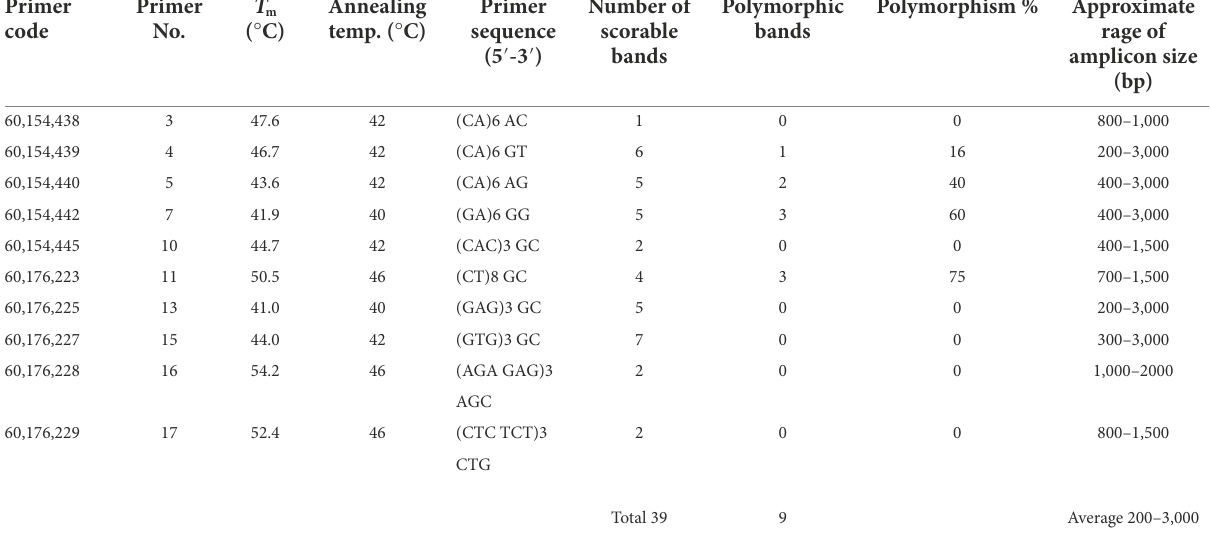
TABLE 2 List of different ISSR (Inter Simple Sequence Repeat) primers used for detecting clonal stability of regenerated H. tuberculatum , melting and annealing temperatures, scoring results of the amplicon profiles. Primer Primer code